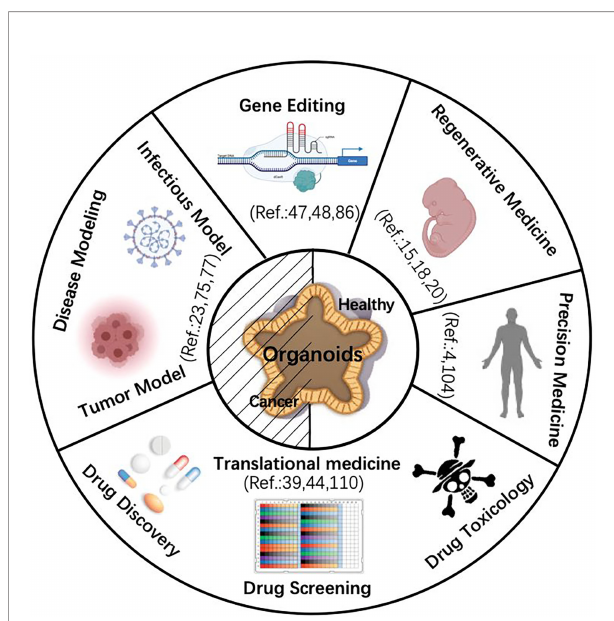
FIGURE 1 | Schematic diagram of organoid application. The center of the diagram shows that both normal and cancer organoids share the fi ve application fi elds indicated by the peripheral parts. [Note: e.g., Ref. 4 refers to reference (4)]. Images are adapted from Servier Medical Art (https://smart.